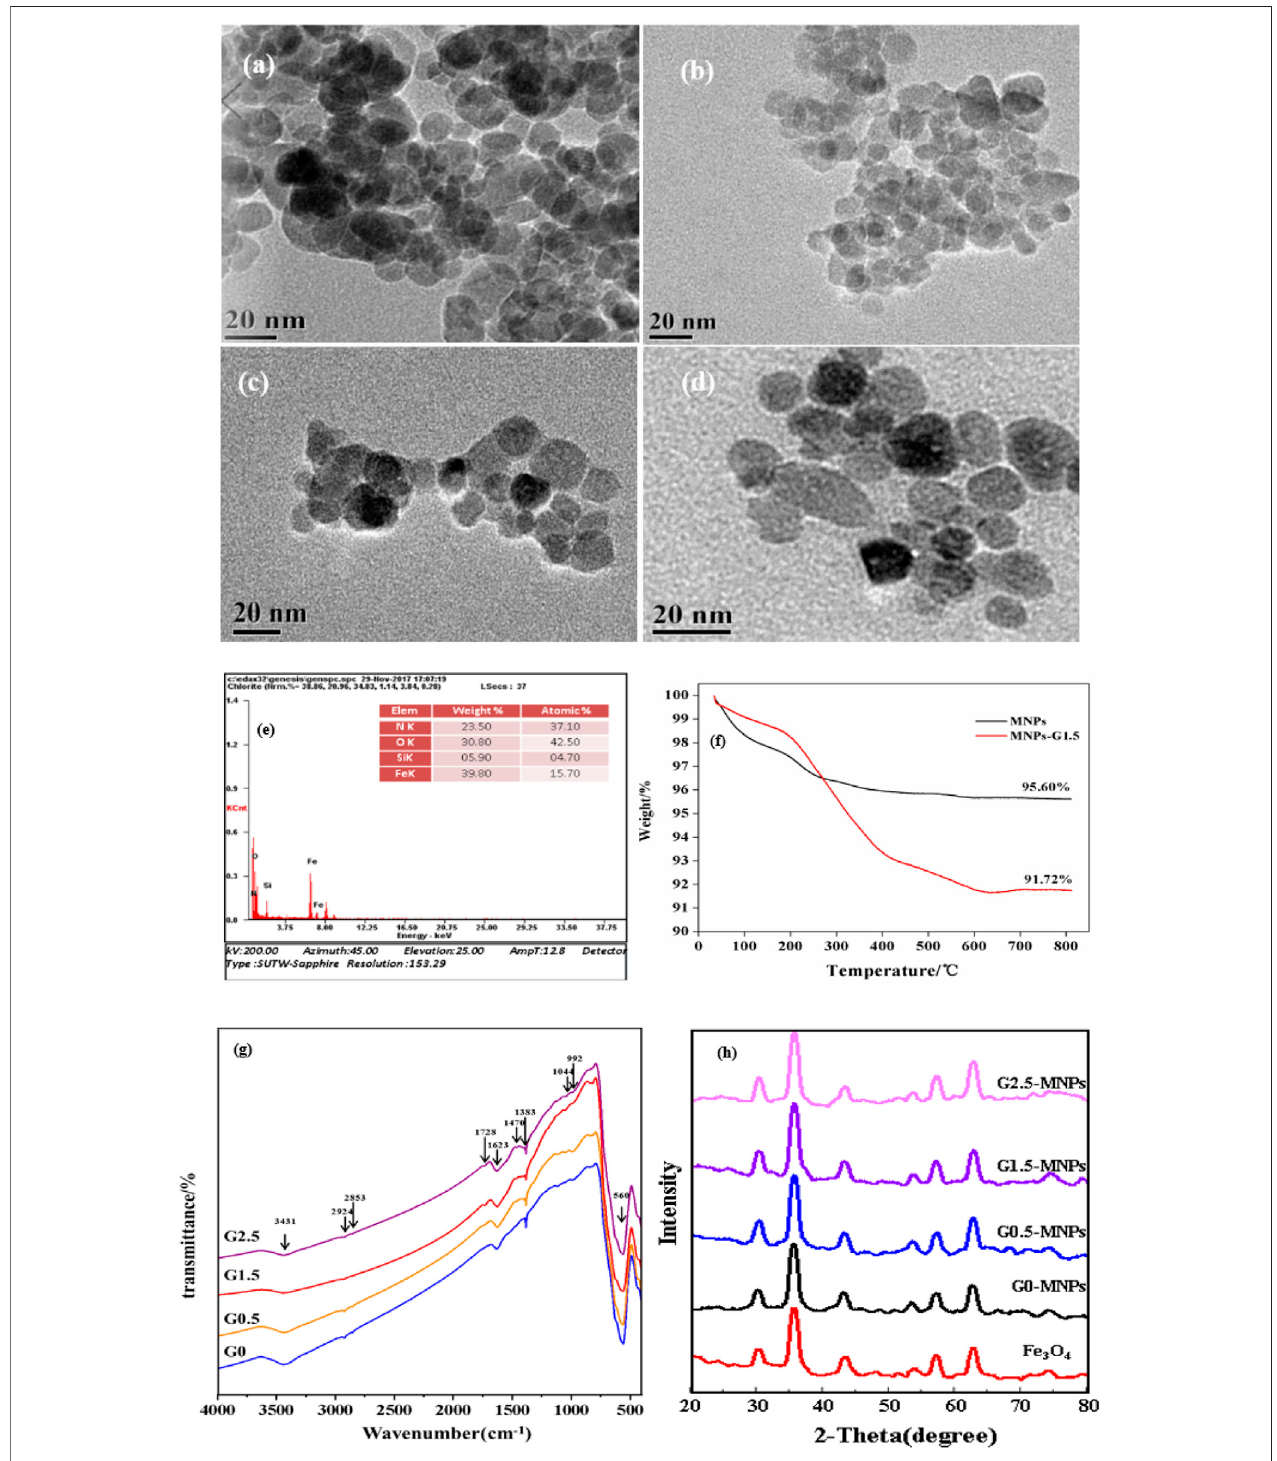
FIGURE2| Characterization. (A) TEMimageofFe 3 O 4 nanoparticles; (B) TEMimageofG0.5-MNPs; (C) TEMimageofG1.5-MNPs; (B) TEMimageofG2.5-MNPs; (E) EDS image of G1.5-MNPs; (F) TGA of G1.5-MNPs; (G) FT-IR spectrums of Gn-MNPs; (H) XRD patterns of MNPs and Gn-MNPs.